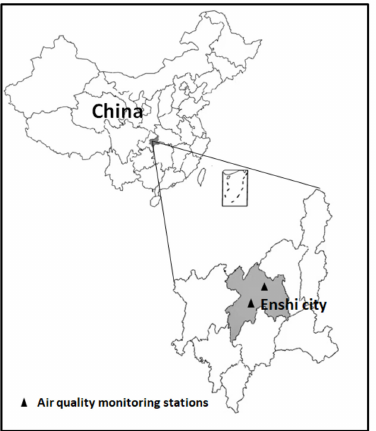
Figure 1. Map of Enshi and the location of national air quality monitoring